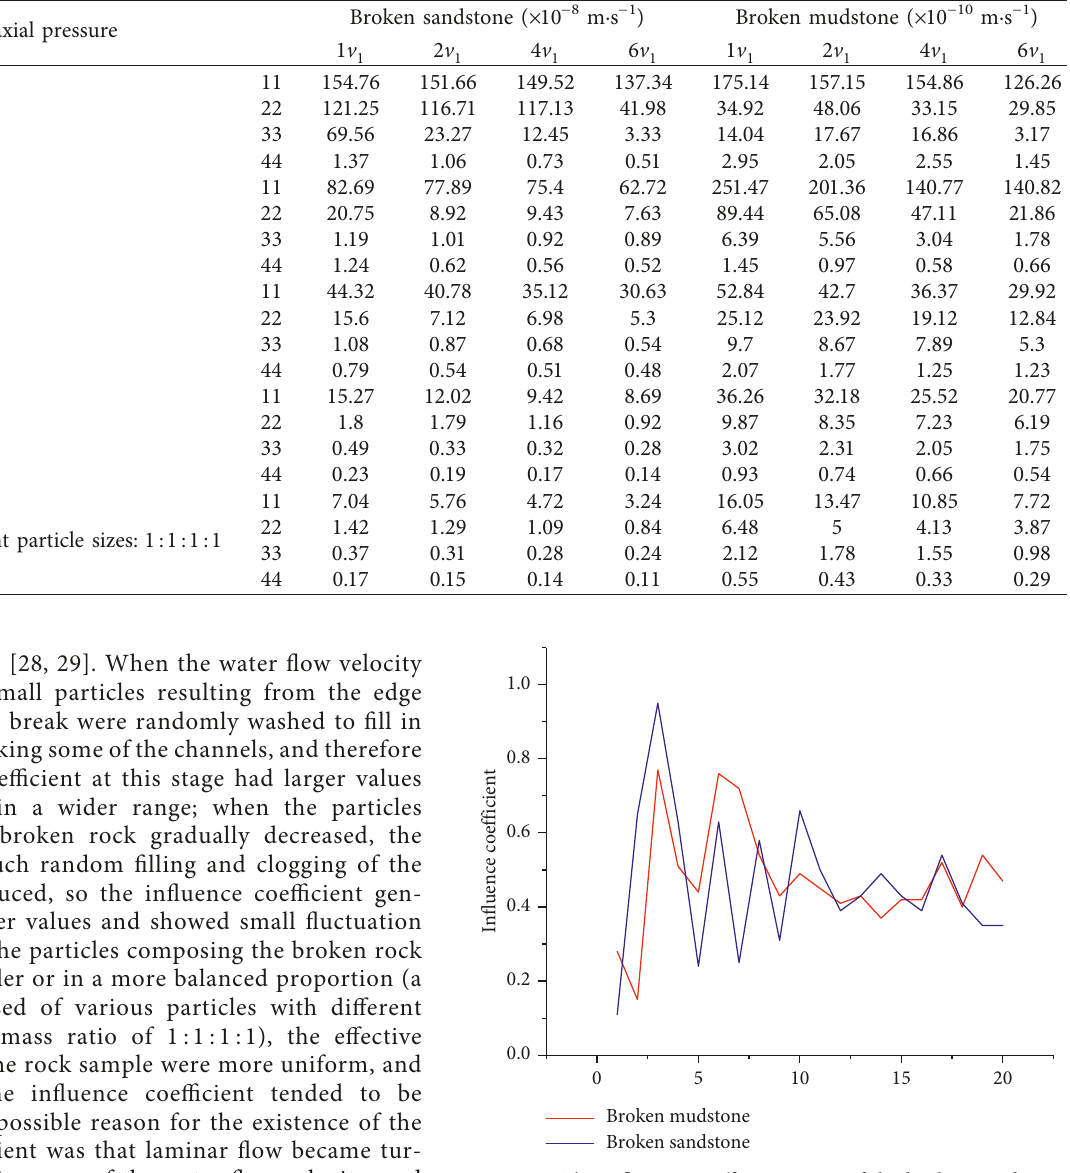
Figure 8: The influence coefficient curve of the broken sandstone and broken